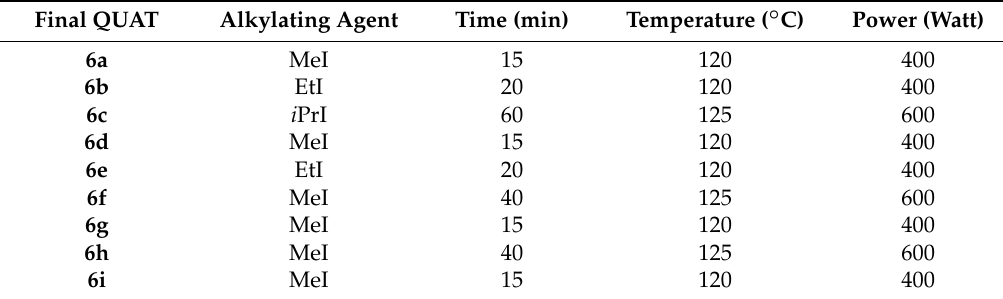
Table 1. Reaction conditions in microwave reactor related to alkylation of tertiary amines.